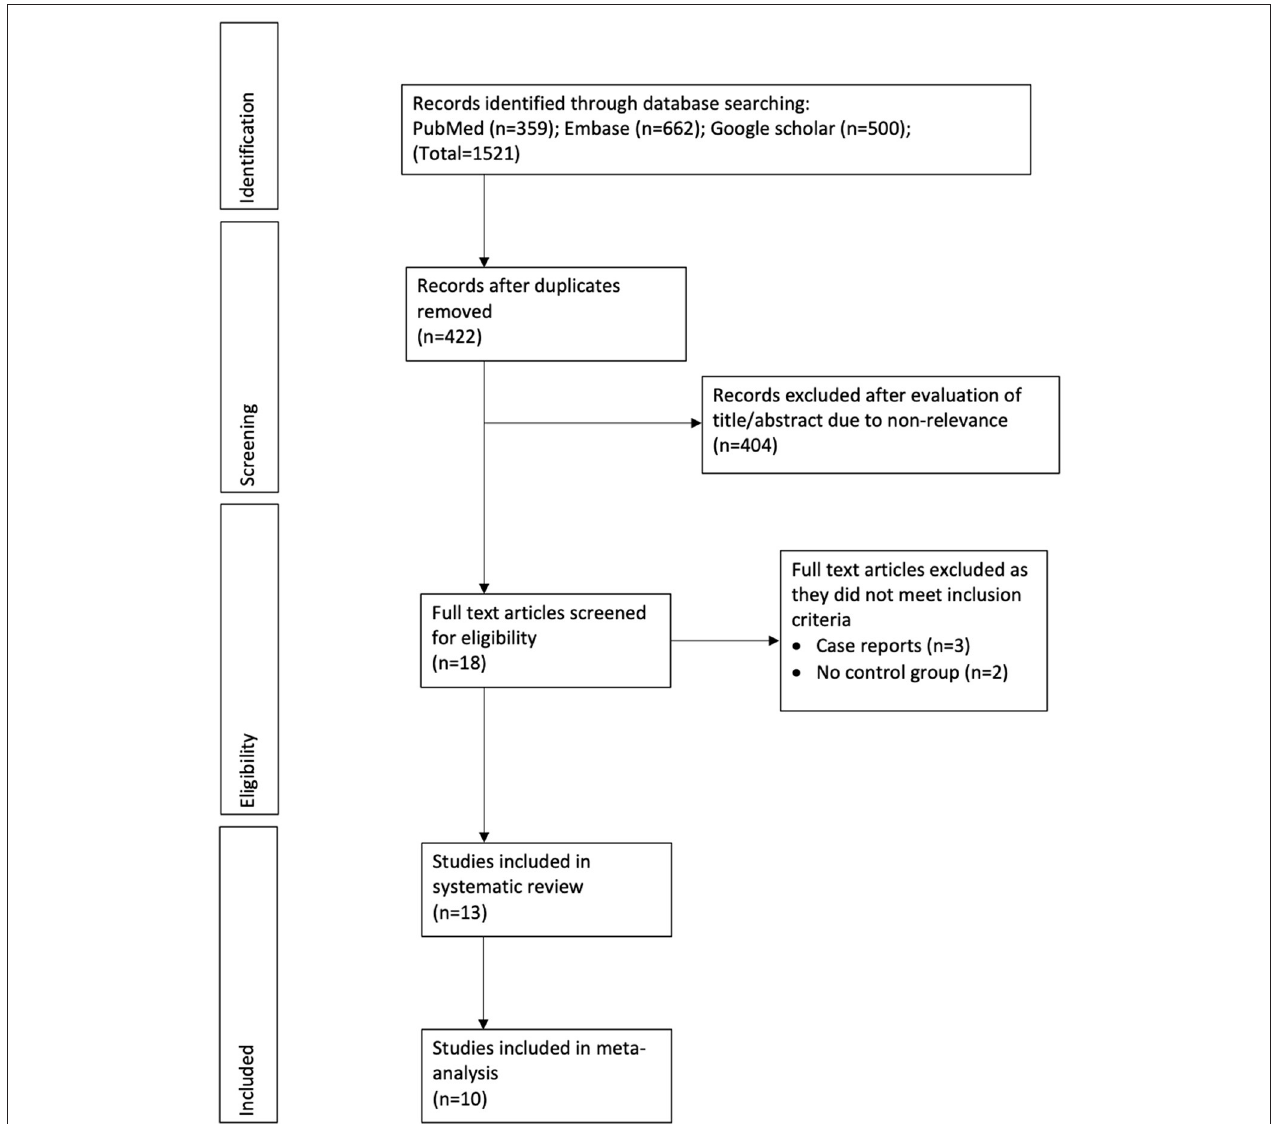
FIGURE 1 | Study flow